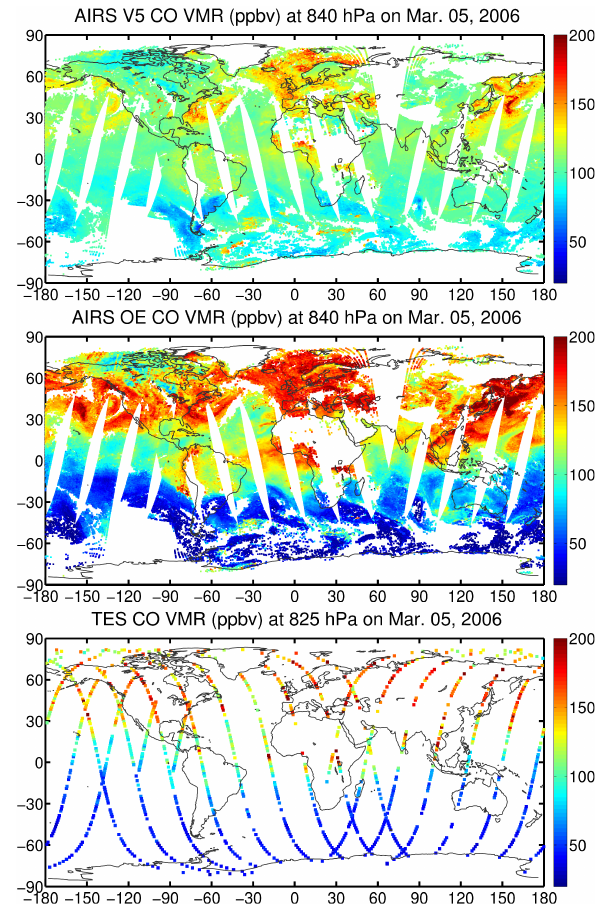
Fig. 6. The comparisons of the global CO maps in the lower tropo- sphere where the red/blue colors indicate relatively high/low values. The top panel shows AIRS V5 CO at 840hPa on 5 March 2006, the middle panel shows AIRS CO at the same level but retrieved using the OE technique, and the bottom panel shows TES CO at a similar